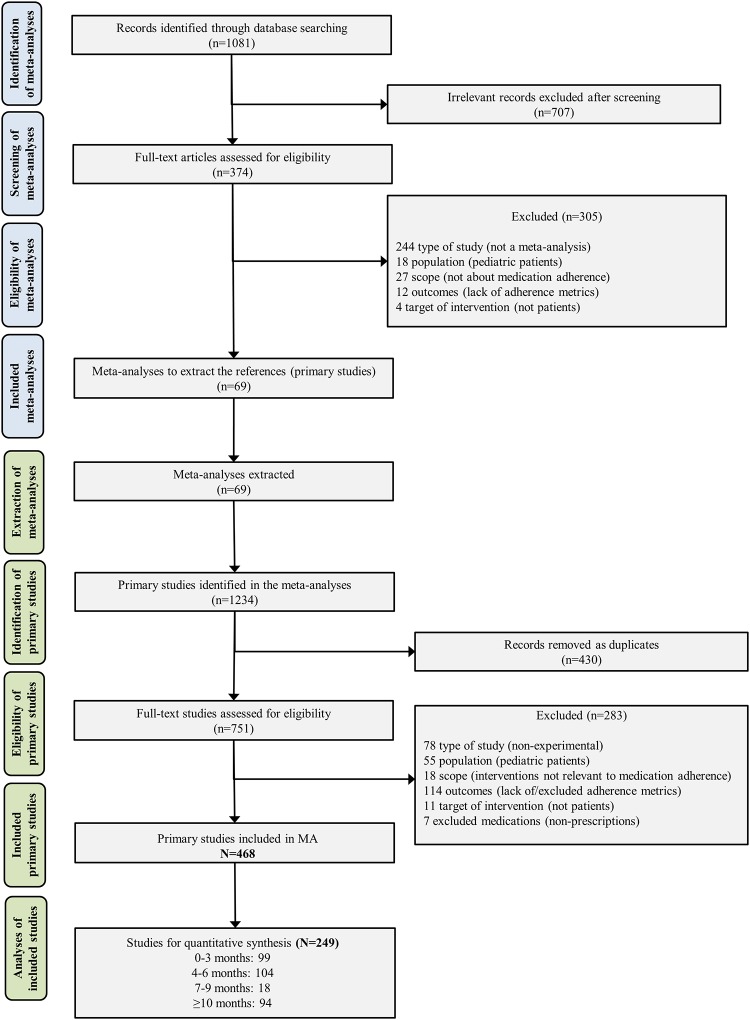
Flowchart of the systematic review process and included studies.